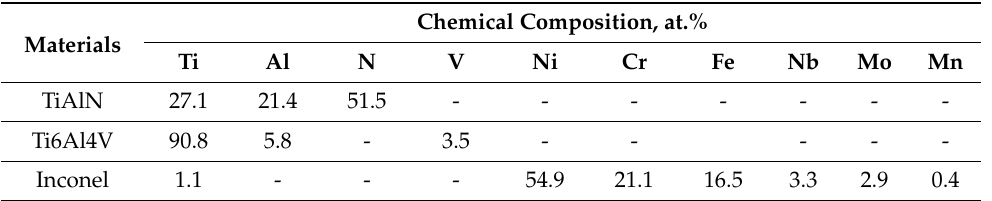
Table 1. The estimated chemical composition of the contacted materials.